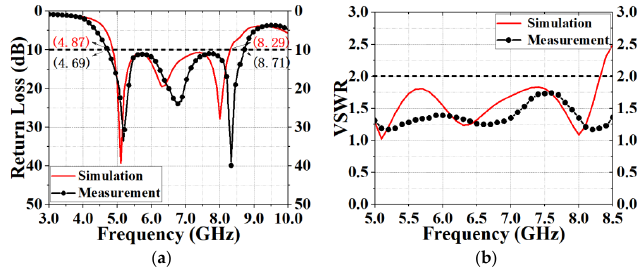
Figure 10. Photo of the front and the back of the designed antenna.